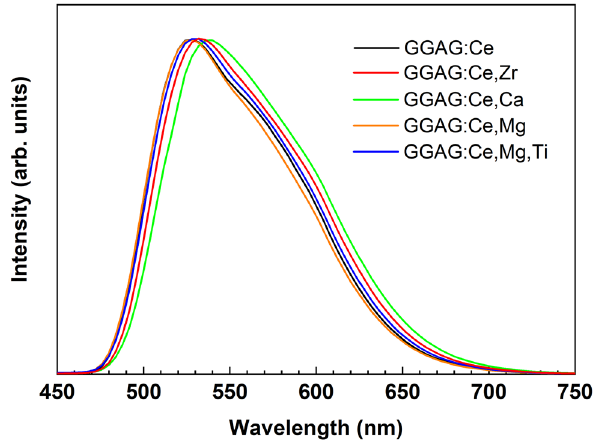
Figure 2. The luminescence spectra of the GGAG:Ce as well as of the GGAG:Ce co-doped single crystals under 45 eV excitation at 10 K. The spectra are normalized at maximum intensity of Ce 3+ emission